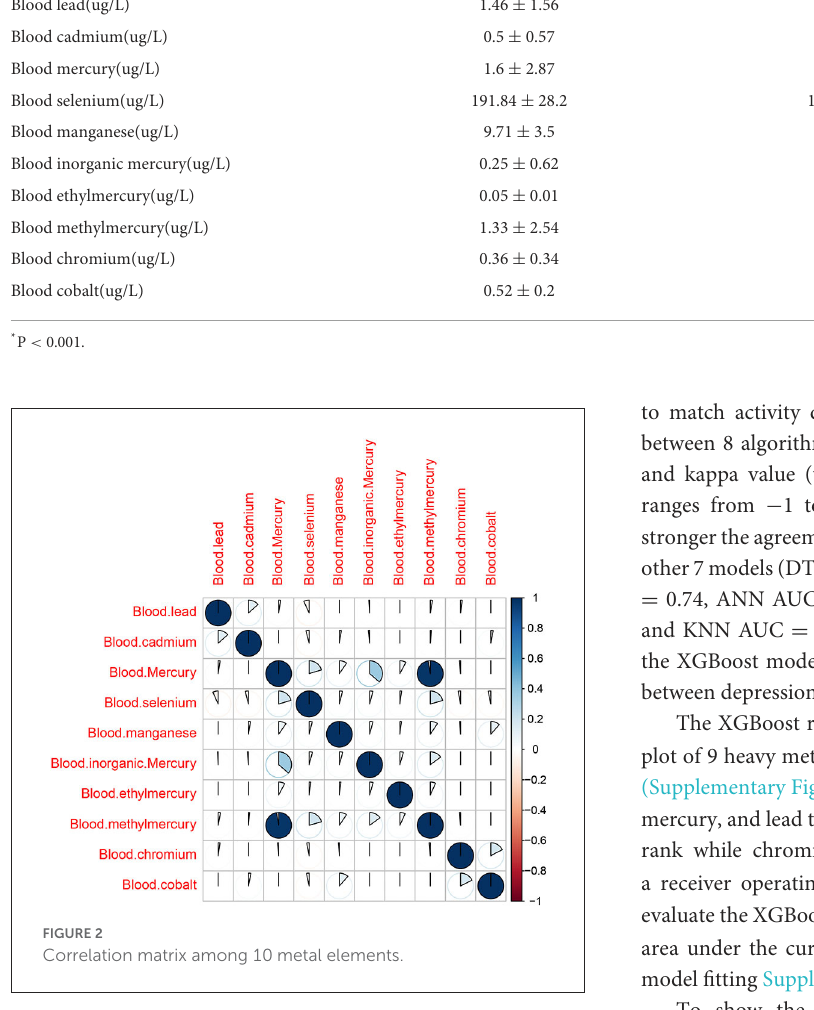
P = 0.002), and blood EtHg (estimate = 3.43, P =